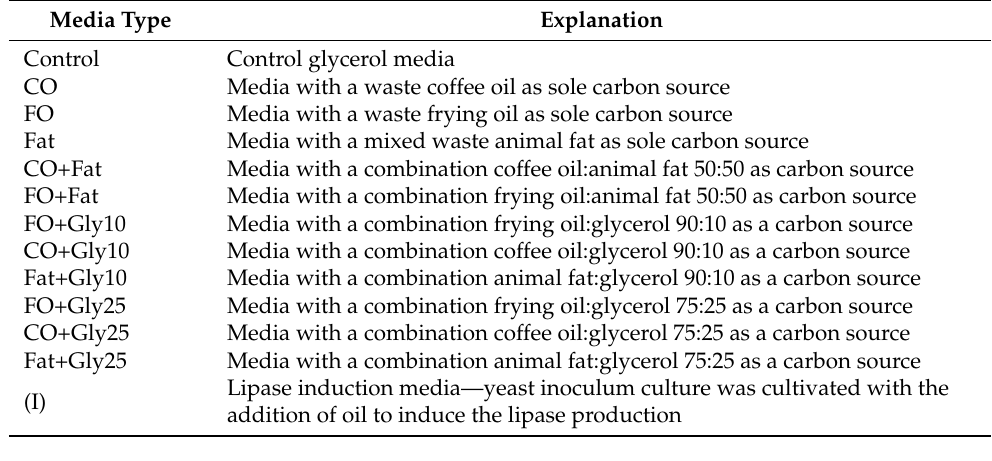
Table 1. List of abbreviations and explanations.